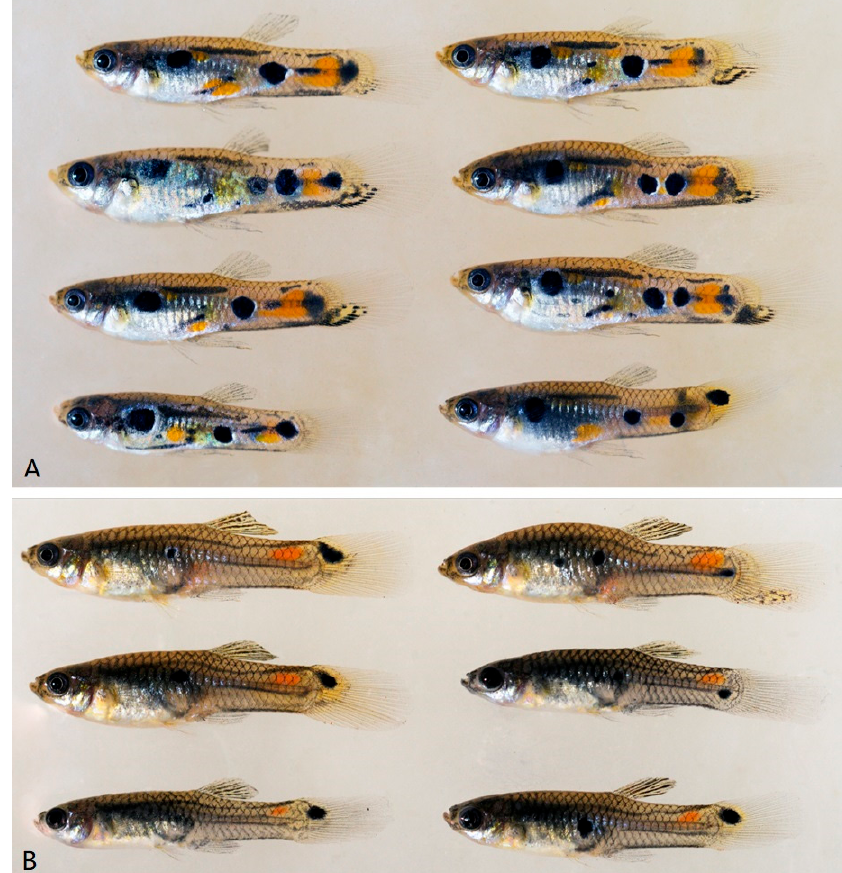
Figure 6. Non-treated Males ( A ) and females ( B ) treated with 17-methyltestosterone of P. obscura (RS strain). Hormone treated females are showing only a part of the male pigmentation patterns. For the phenotype of untreated females see Supplementary Figure S17.